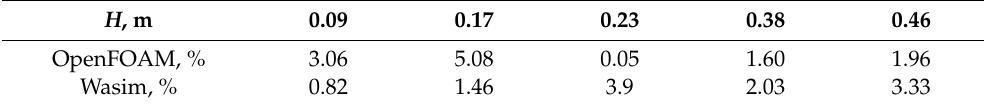
Figure 18. Difference of numerical and experimental nondimensional pitch amplitudes the 6750 TEU containership.